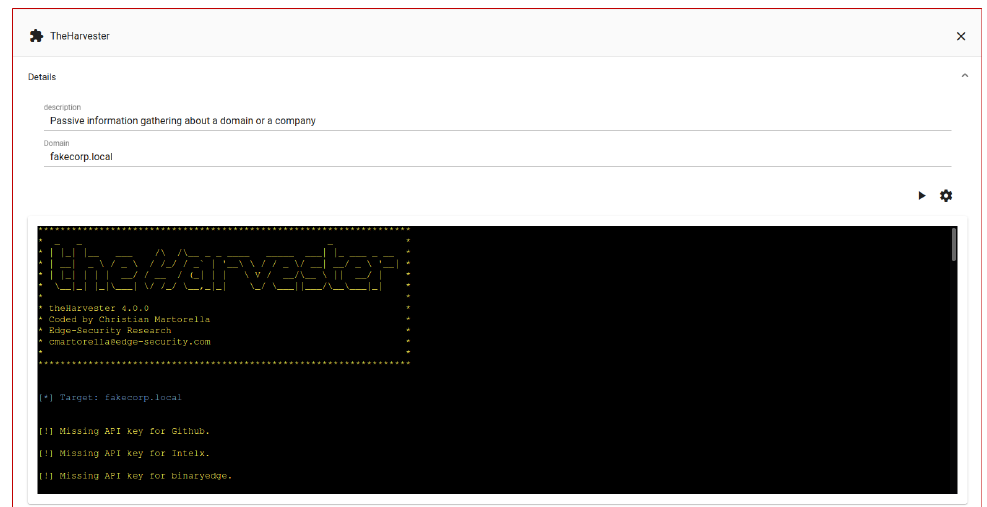
Figure 10. theHarvester module execution.